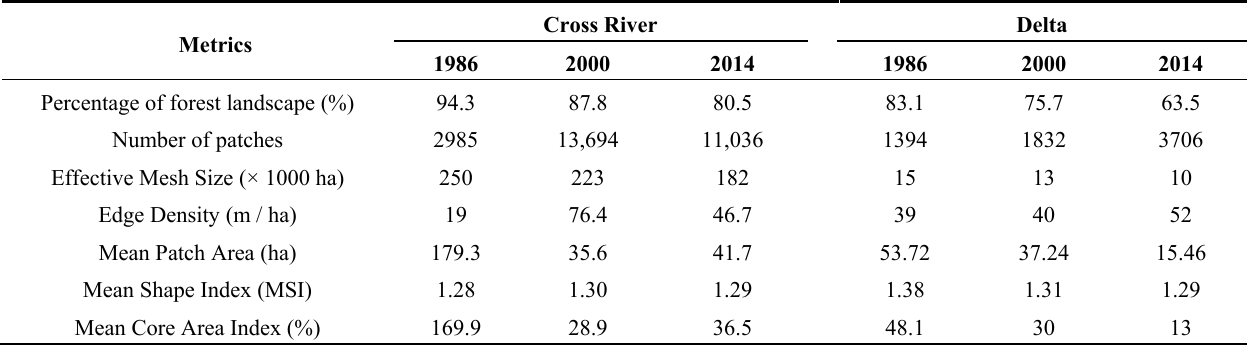
Table 6. Results of landscape metrics used in study for Cross River and Delta from 1986 to 2014.